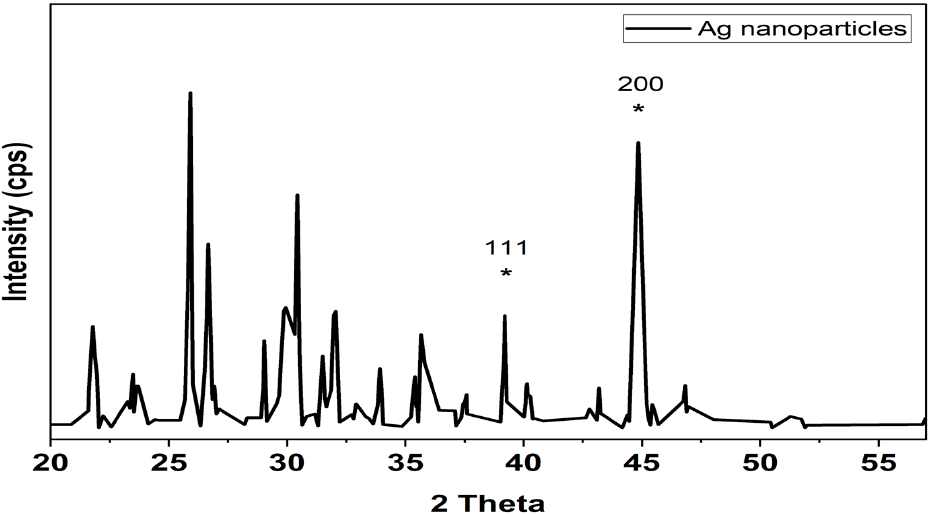
Figure 3. XRD analysis of silver nanoparticles biologically prepared with Emericella dentata filtrate. * Peaks are attributed to silver’s (1 1 1) and (2 0 0) planes of diffraction. The (1 1 1) and (2 0 0) diffraction peaks in an XRD pattern can be indexed